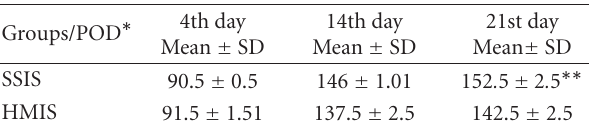
Table 2: The bursting pressure mmHg in the SSIS and HMIS